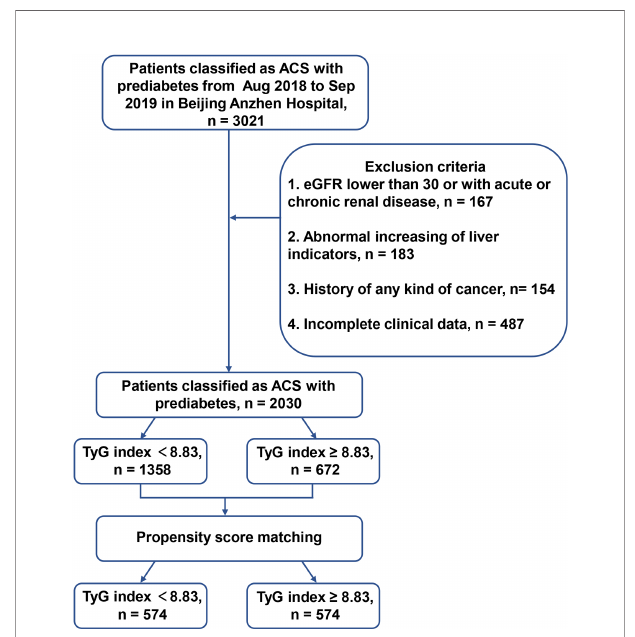
FIGURE 1 | The fl ow chart of enrolled patients. ACS, acute coronary syndrome; HbA1c, glycosylated hemoglobin A1c; DM, diabetes mellitus; eGFR, estimated glomerular fi ltration rate; TyG, triglyceride-glucose.